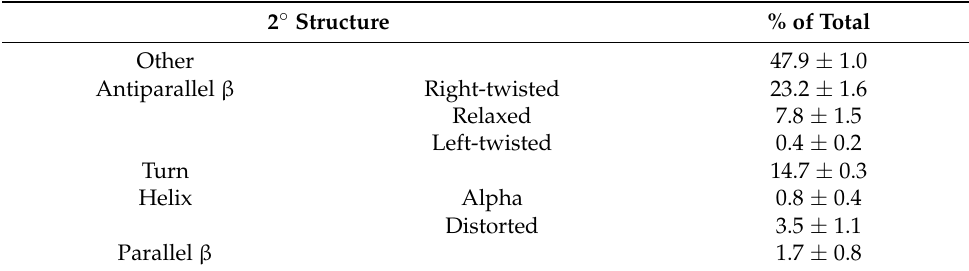
Figure 1. CD profile of WYR (10 µ M) at 25 ◦ C shows positive ellipticity >225 nm, a shoulder between 210–220 nm, a strong negative band at ~200 nm and a trough that remains in the negative at ~190 nm. N = 10. Each point represents mean with SEM. Table 1. BeStSel Secondary structure estimations for